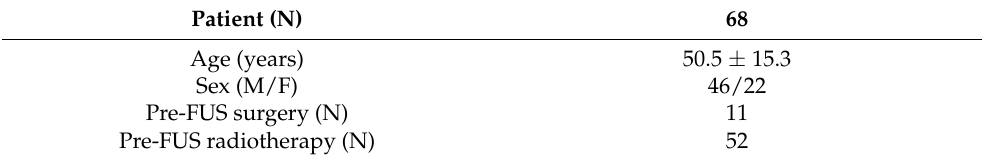
Table 1. Demographic and pre-FUS session summary data of all-included